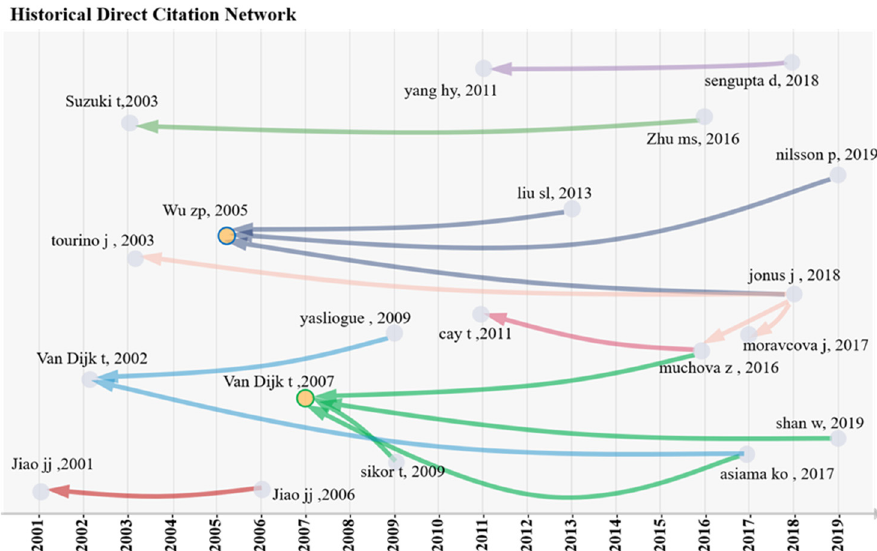
Figure 4. Historical direct citation network of top-cited papers in the field of land consolidation during 2000–2020.